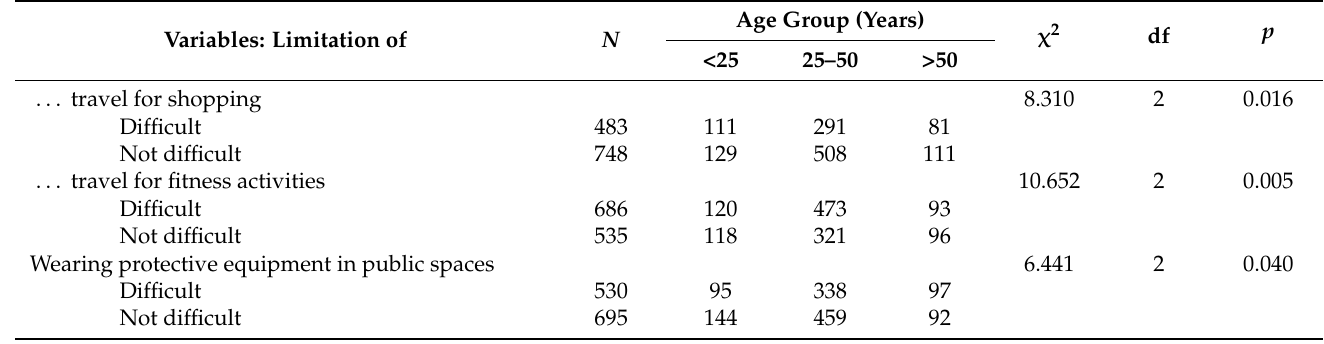
Table 6. Table of associations: restrictive measures by age of respondents.